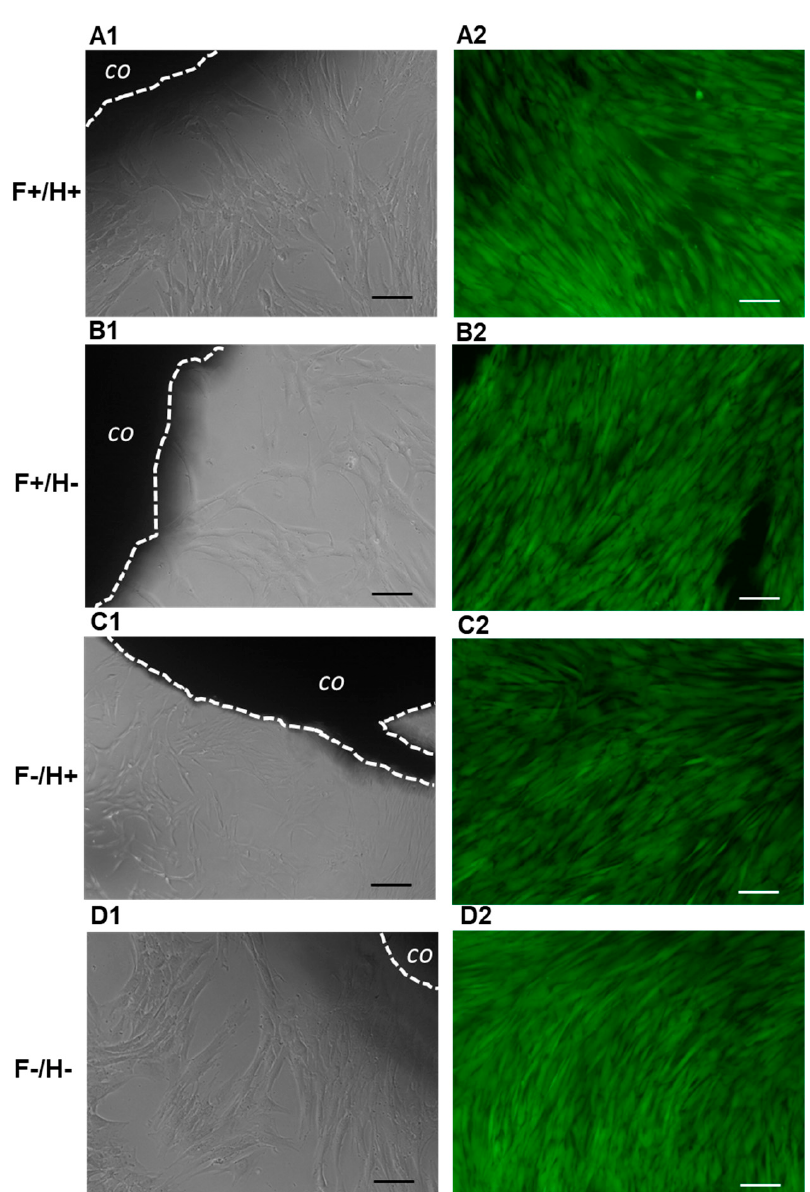
Figure 10. Micrographs showing fiber/hydrogel (F/H) composites in contact with hDFs, as observed via inverted microscopy on day 5 (column 1), and on day 8 after Calcein AM staining (column 2): ( A1 , A2 ) both fibers and hydrogel loaded with Dexa; ( B1 , B2 ) fibers loaded with Dexa and unloaded hydrogel; ( C1 , C2 ) unloaded fibers and hydrogel loaded with Dexa; ( D1 , D2 ) both fibers and hydrogel unloaded. In the micrographs, “co” indicates the composite. Scale bar is 100 µm.